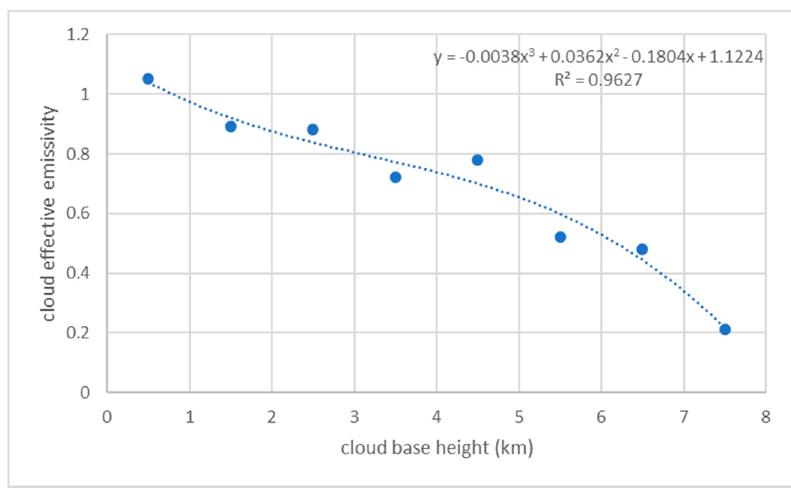
Figure 3. Scatter plot of cloud base height and cloud effective emissivity [29]. The cloud emissivity in Figure 3 is the mean value of observed emissivity within each 1 km interval of cloud base height starting from 0 km; thus, a more robust model to derive cloud emissivity from cloud base height would be a type of Gaussian process. Since we did not have the deviation data of cloud emissivity for each interval of cloud base height, Equation (12) was used as an approximation of real cloud effective emissivity. Figure 4 shows the cloud fraction, TOA longwave radiative flux and estimated cloud effective emissivity at UTC 3:00 p.m. on 11 February 2017. It is clear that the emissivity at the high cloud fraction is high, which follows the understanding of cloud emissivity. The cloud effective emissivity in Figure 4c is in good agreement with the longwave radiative flux in Figure 4b. Thus, the method of Equation (12) follows the pattern of longwave radiative flux from clouds in